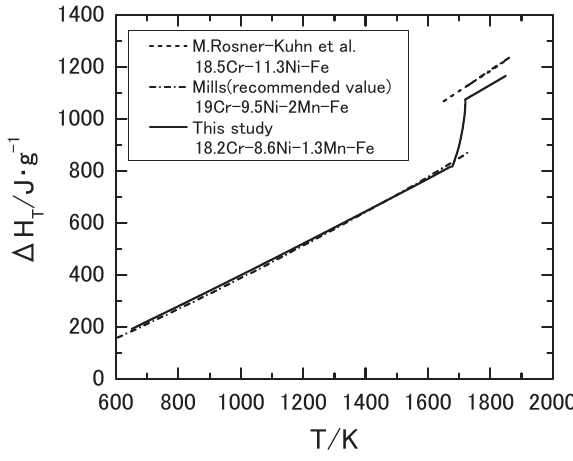
Figure 4. Comparison between literature values and the present work for heat content of SUS304.